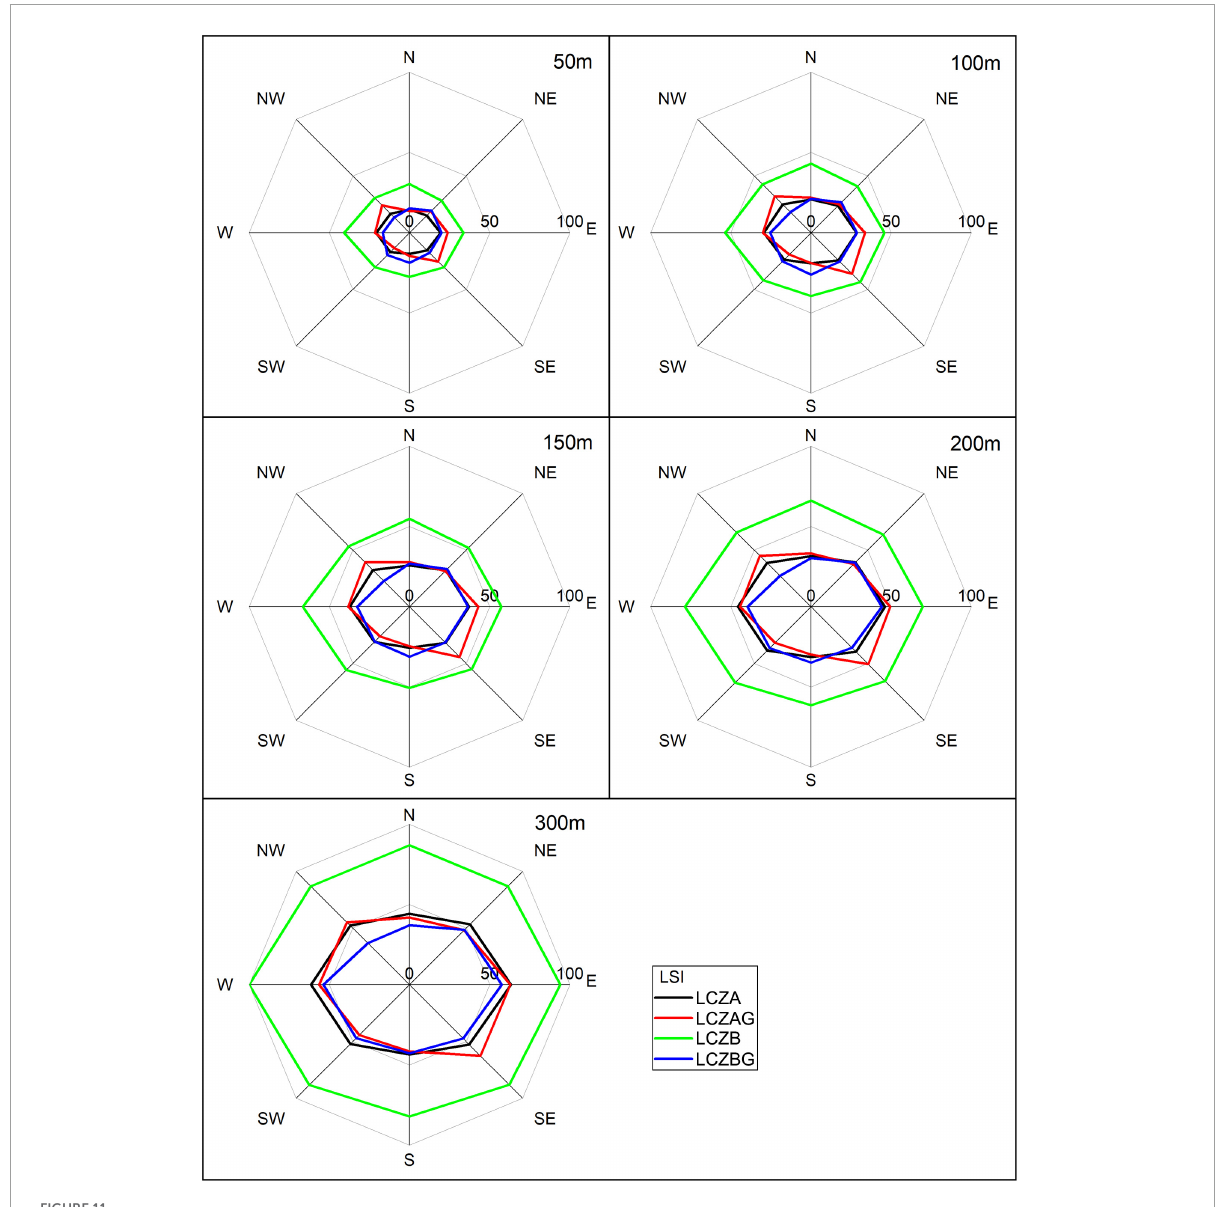
FIGURE11 The LSI of buildings at eight directions around different urban